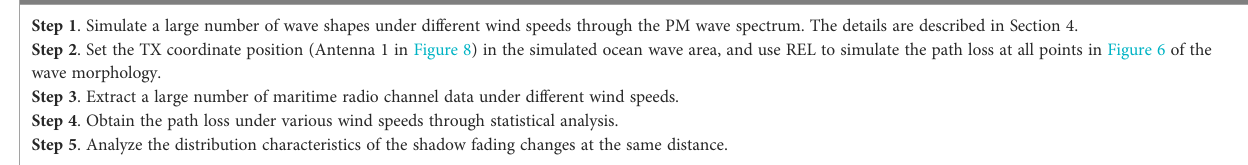
TABLE 2 Program of model veri fi cation.